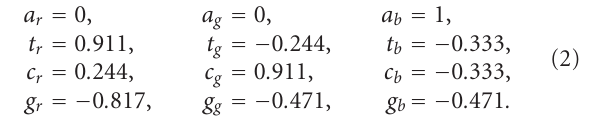
Figure 2: Spectrogram of random DNA of length 60kbp with bases A , T , C , and G with periods 15, 13, 11, and 9, respectively. The nu- cleotide A is represented by the color blue, T by red, C by green, and G by yellow. Arrows mark the di ff erent periodicities.